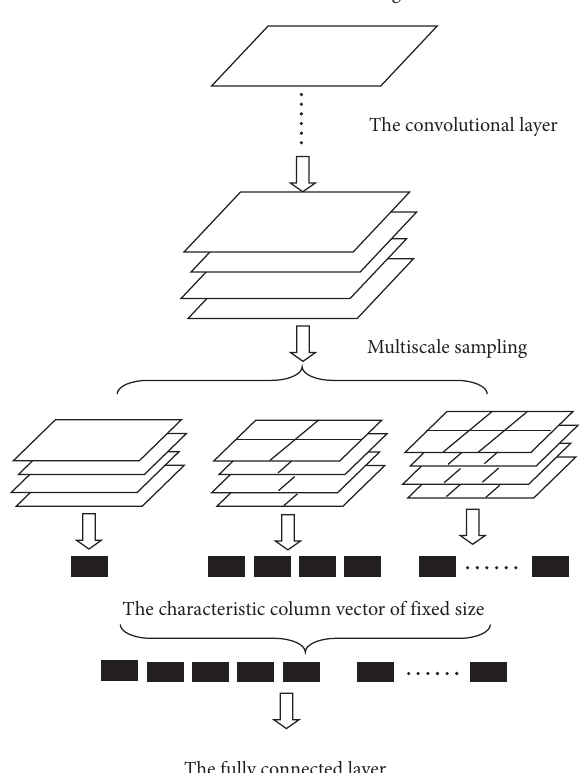
Figure 3: Illustration of the multiscale